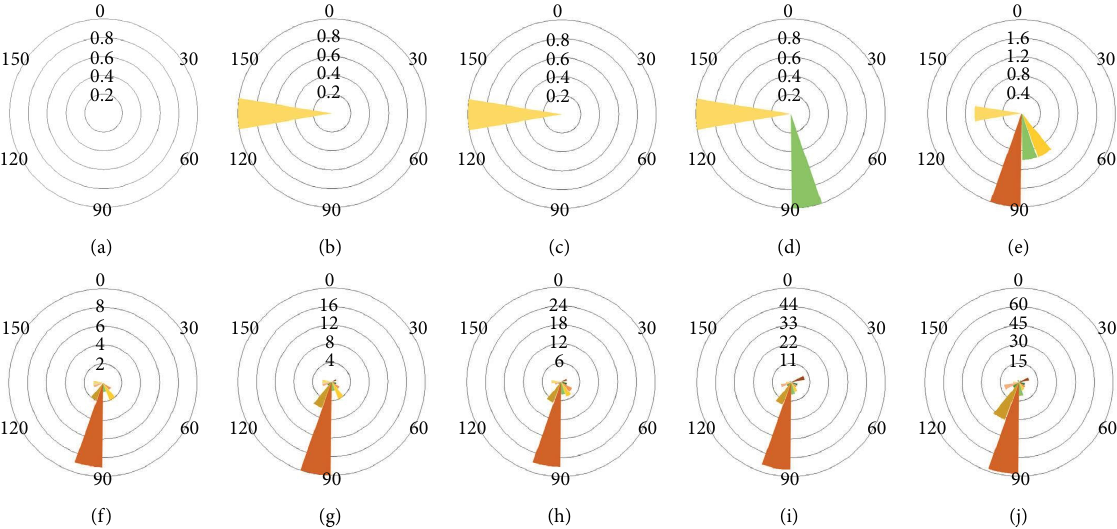
Figure 10: Evolution characteristics of the rock crack azimuth angle under pure rolling of the disc cutter: (a)–(j) crack azimuth distribution at 10 sampling